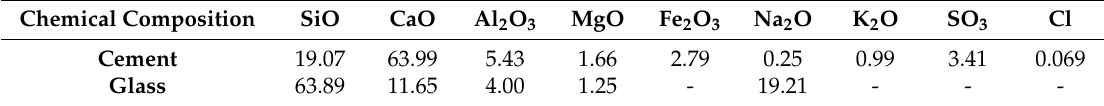
Table 1. Chemical composition of cement and